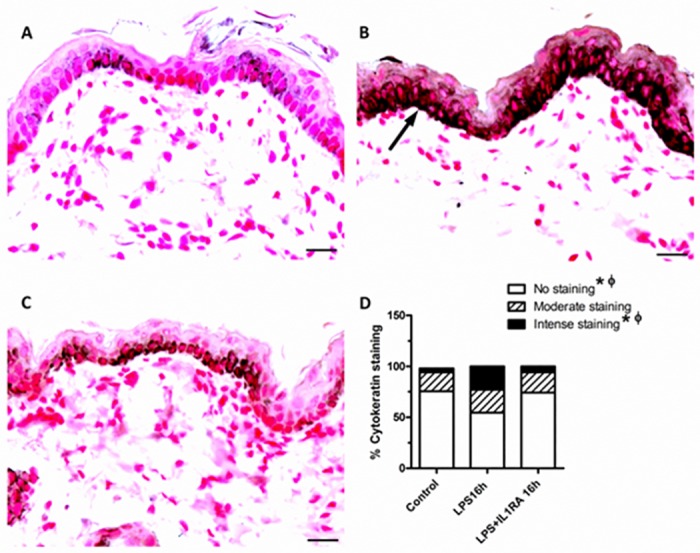
Pancytokeratin expression.Representative photomicrographs for pancytokeratin (1:2500) immunohistochemical staining of fetal skin. (A) control; (B) LPS at 16 h; (C) LPS and IL-1ra at 16 h exposure. (D) Graph shows the comparison between groups in the percent of positive cells of different intensity stain; intense (arrow), moderate and no stain (magnification bar represents 20 μm). *indicates a significant difference in the percent of positive cell between LPS at 16 hours and untreated control group. ɸ indicates a significant difference in the percent of positive cell between LPS group and LPS plus IL-1ra group at 16 hours.